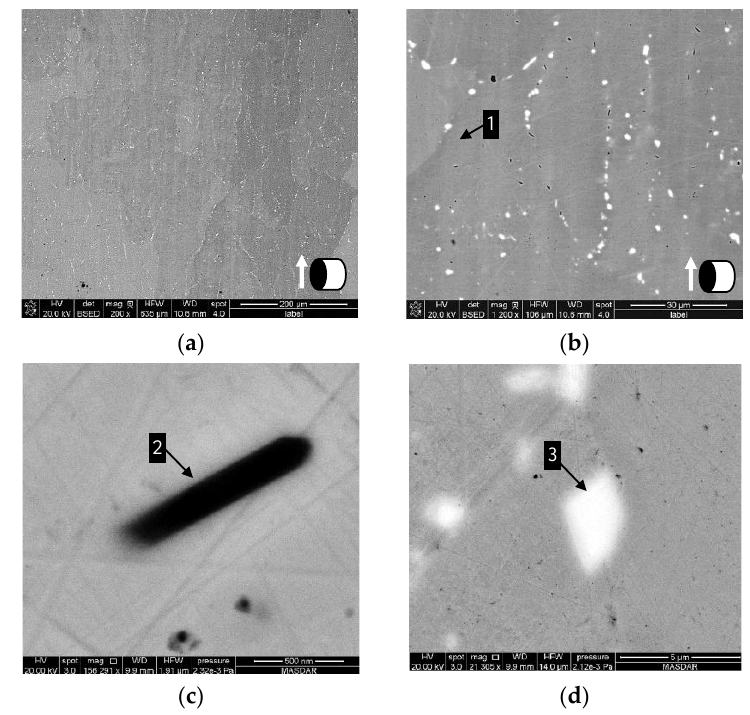
Figure 14. ( a ) Microstructure of hot isostatic pressing (HIP)-treated IN718 alloy; ( b ) magnified image showing the grain boundary precipitates after HIP-treatment; ( c , d ) enlarged images showing δ-phase and carbide phase, respectively. The numbers correspond to the EDS spot analysis in Table 1.